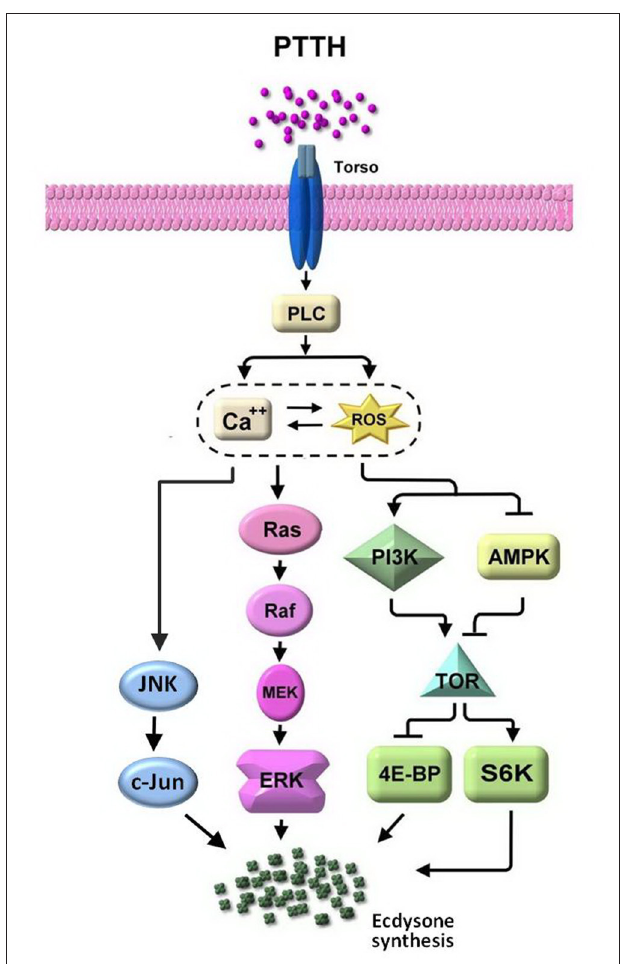
FIGURE 9 | The signaling network involved in PTTH-stimulated ecdysteroidogenesis in Bombyx PGs. See text for details.